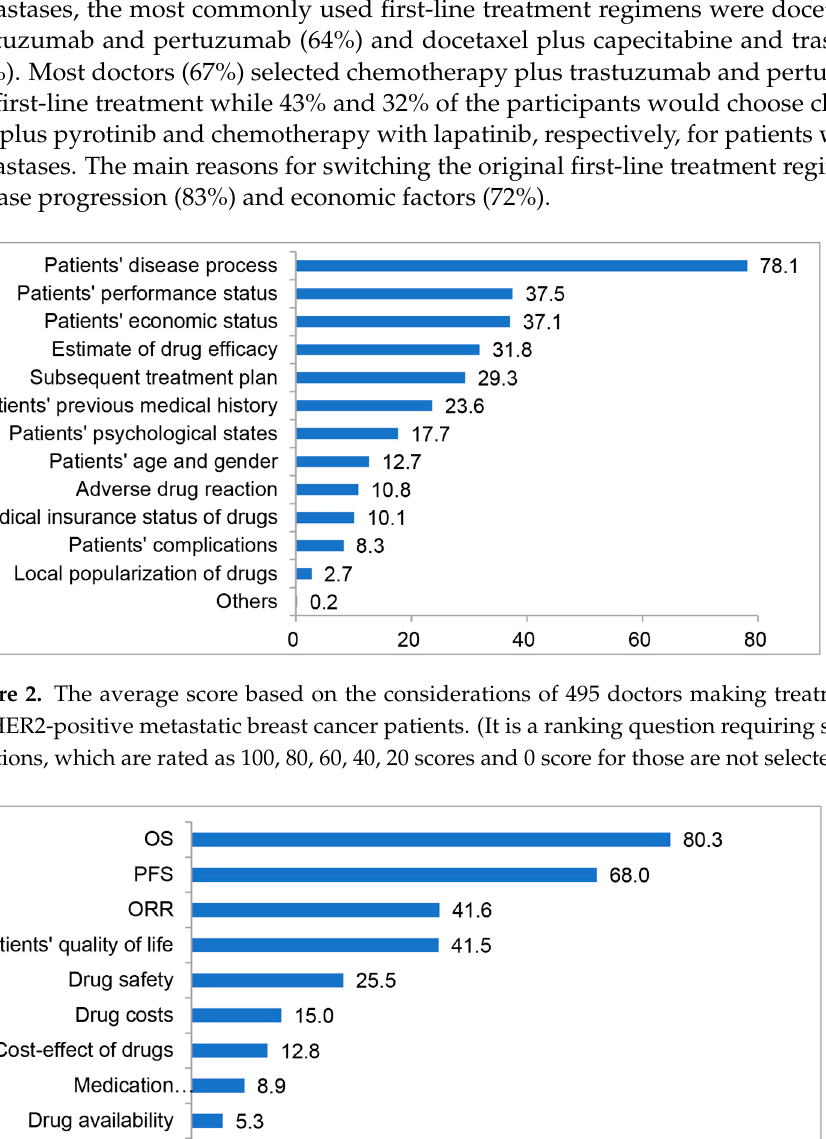
Figure 3. The average score based on the considerations of 495 doctors when choosing drugs for HER2-positive metastatic breast cancer patients. (It is a ranking question requiring selection of 5 options, which are rated as 100, 80, 60, 40, 20 scores and 0 score for those are not selected Doctors selected up to 5 items and scored 100, 80, 60, 40, and 20, respectively).